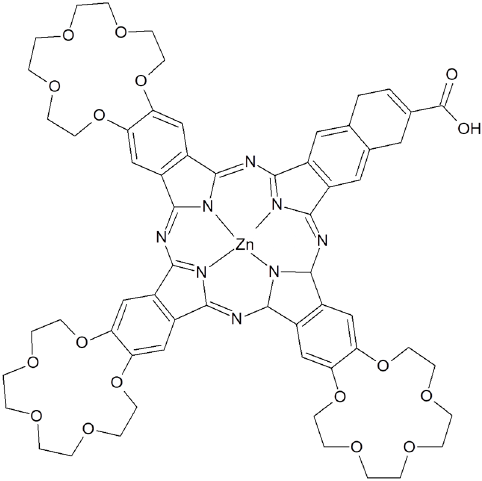
Figure 24. Chemical structure of ZnPc with three 15-crown-5 ether functional groups and one carboxyl group [134].